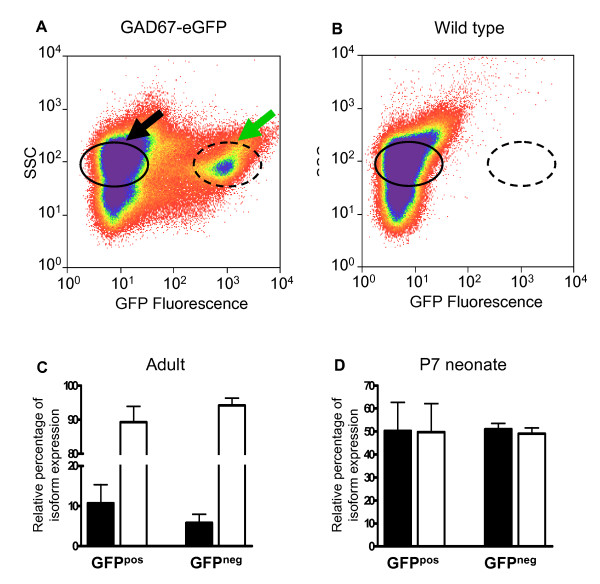
Developmental regulation of SNAP-25 isoform expression in GABAergic neurons. Panels A and B show a pair of graphs comparing cell populations prepared from acutely dissociated adult cortex of GAD67-GFP (ΔNeo) and nontransgenic wild type mice, respectively, after fluorescence-activated cell sorting (FACS). The selectivity of the fractionation is demonstrated by the distinct population of GFP-positive cells (dashed oval, panel A) that was readily distinguished in cells derived from GAD67-GFP (ΔNeo) mice, but was absent in preparations from wild type animals (panel B). The arrows in A indicate the two sorted cell populations, GFP-positive (green arrow) and -negative (black arrow), used for molecular analysis. Panel C shows the relative levels of SNAP-25a (solid bar) and SNAP-25b (white bar) RNA transcripts in adult neurons from GFP-positive (GFPpos, n = 4) and -negative (GFPneg, n = 2) populations. Panel D, SNAP-25 isoform RNA transcript expression in sorted immature neurons obtained from cortex of P7 neonates (GFPpos, n = 7; GFPneg, n = 4). Note that in contrast to the earlier developmental time point where comparable levels of the two isoform transcripts are expressed in both GFPpos and GFPneg cell populations, mature neurons of both populations express predominantly the SNAP-25b transcript.